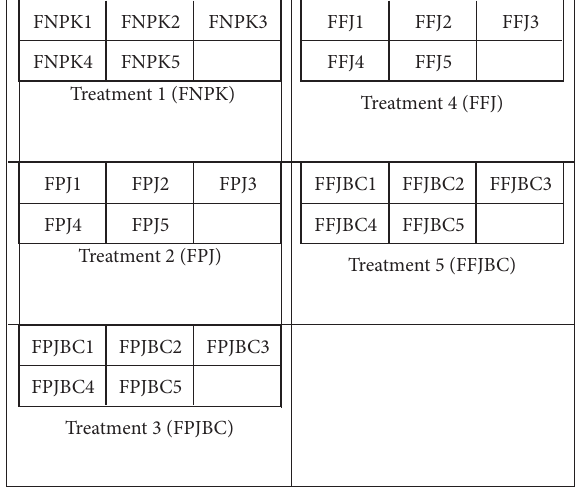
Figure 1: Experimental design with randomized treatments in